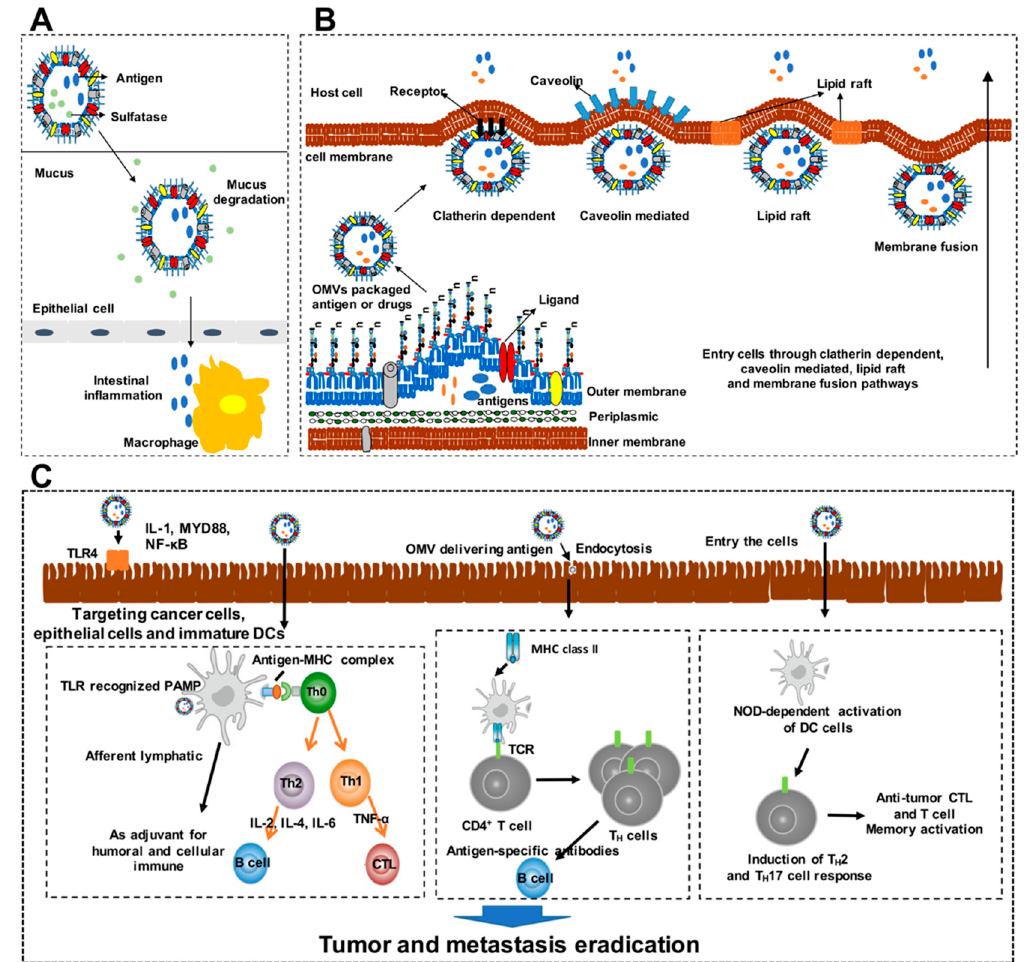
Figure 1. Design of mechanisms underlying the functions and immune modulation of outer membrane vesicles (OMVs) recombinant with heterologous antigens and the pathways through which they gain entry into host cells. ( A ) OMVs can also cross the mucus barrier in the gut and reach the intestinal epithelium, delivering bacterial antigens to the underlying macrophages, triggering intestinal inflammation. ( B ) Mechanisms of OMV entry. Pathogenic Gram-negative bacteria are thought to utilize OMVs to interact with host cells during infection. For example, bacteria can use OMVs to mediate the delivery of virulence factors, such as toxins, into host cells, including immune cells, and OMVs may enter host cells through various endocytic routes including clathrin-dependent, caveolin-mediated, lipid raft, and membrane fusion pathways. The most frequently reported mode of OMV entry into host cells involves lipid rafts as OMVs could fuse with lipid rafts to facilitate their entry into host cells. The pathways of cholesterol-independent and clathrin-mediated endocytosis are independent of lipid rafts. Moreover, OMVs can enter host cells via the mechanism of membrane fusion in a size-dependent manner. ( C ) A model for OMVs targeting cancer cells, epithelial cells, and immature dendritic cells (DCs) to mediate immune responses. OMVs can interact directly with